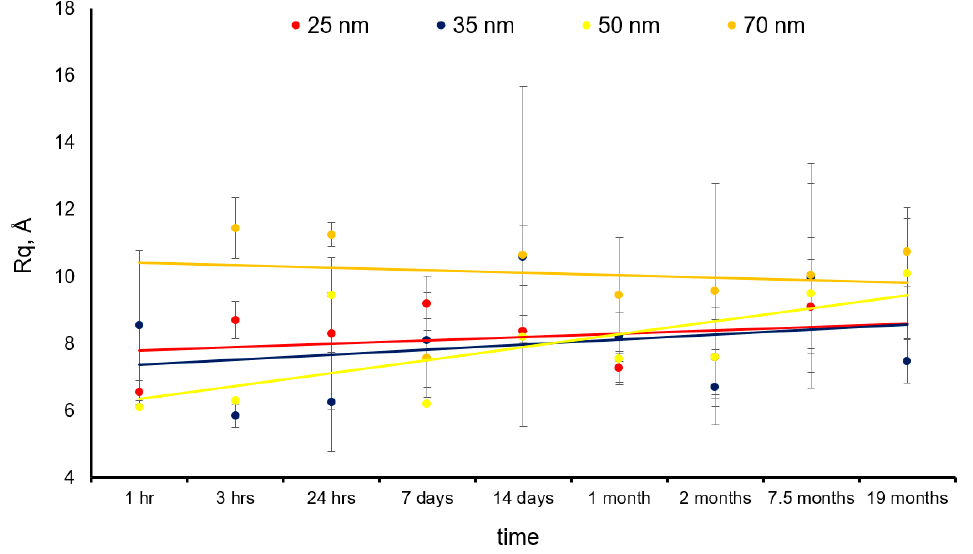
Figure 5. Time evolution of the RMS roughness of Ag thin films of different thicknesses.